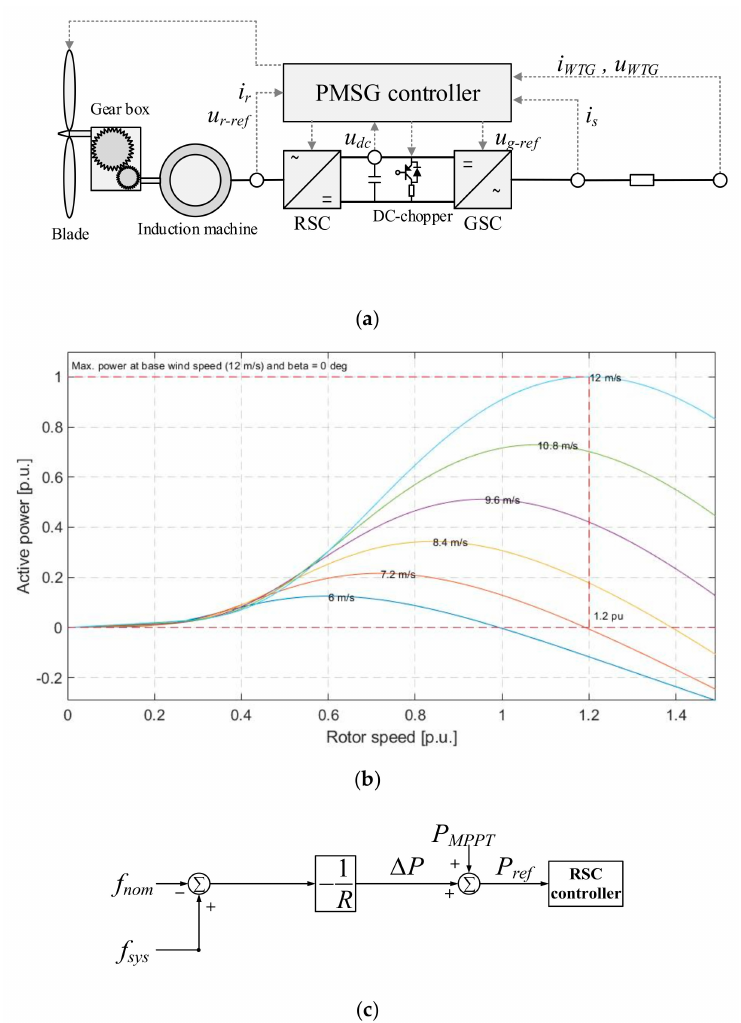
Figure 1. The PMSG model. ( a ) Typical configuration of a PMSG; V r , I r : voltage and current in the rotor circuit; V t , I t : voltage and current at the terminal; V r,ref , V t,ref : reference RSC and GSC voltage; V DC : DC-link voltage; V g , I g : voltage and current at the point of common coupling (PCC); ω r : rotor speed; β : pitch angle. ( b ) Operational characteristics of a PMSG. ( c ) Operational characteristics of a frequency stabilization